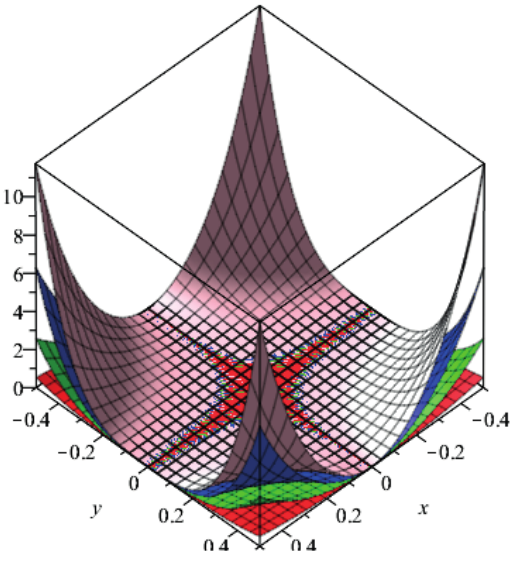
Figure 24: Plot of M-Polynomial of Dominating David Derived Network of third